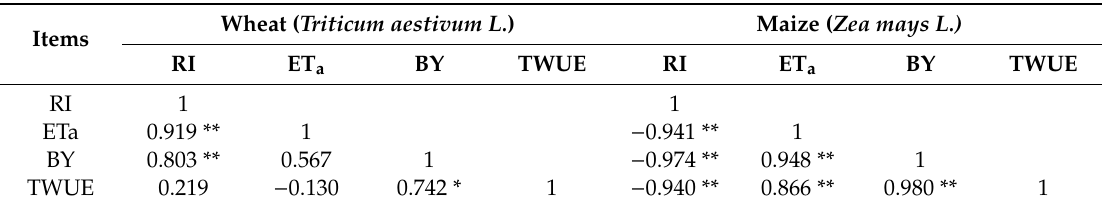
Table 8. Pearson correlation of rainfall plus irrigation (RI), ETa, BY, and TWUE in the three straw incorporation treatments during 2011 −